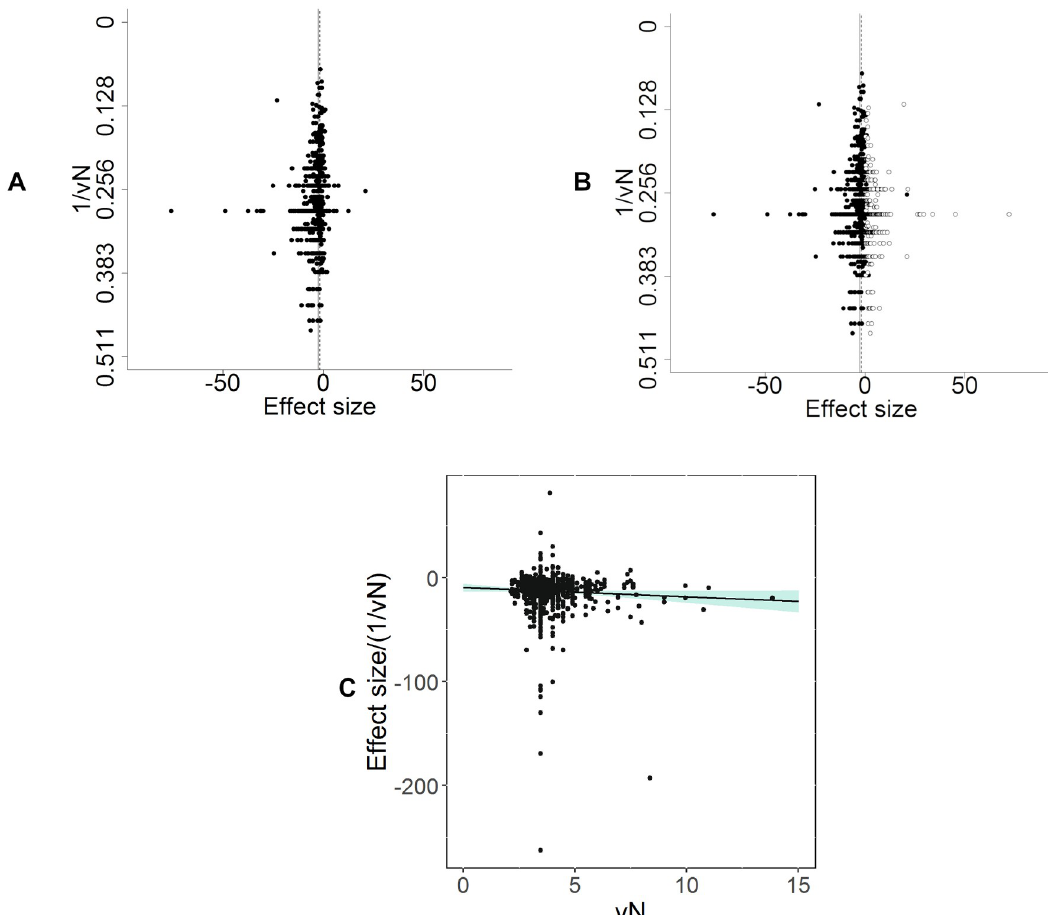
Fig 8. Assessment of publication bias in modelling experiments in which a pain-related outcome was used (data set 1a). (A) Visual inspection of the funnel plot suggests asymmetry. Filled circles represent reported experiments. Solid line represents global effect size, and dashed line represents adjusted global effect size. (B) Trim and fill analysis imputed theoretical missing studies (unfilled circles). Filled circles represent reported experiments. Solid line represents global effect size, and dashed line represents adjusted global effect size. (C) Egger’s regression indicated small study